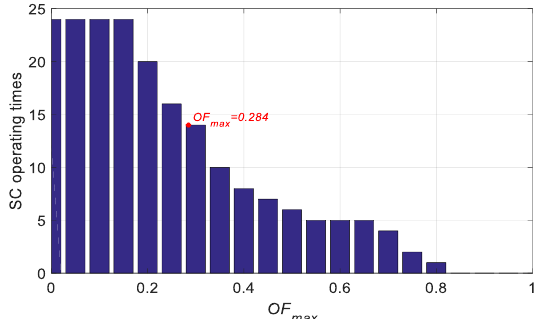
Figure 10. Sensitivity of the SC operation frequency versus OF max .